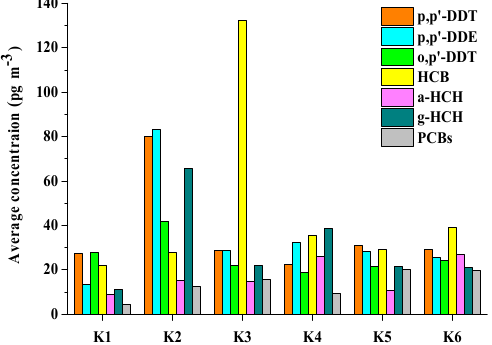
Figure 3. Distribution of OCPs and PCBs in the atmosphere of different sites of Kathmandu (K1, Cropland; K2, Market; K3, In- dustrial; K4, Tourist; K5, Residential; K6, Industrial and Farmland